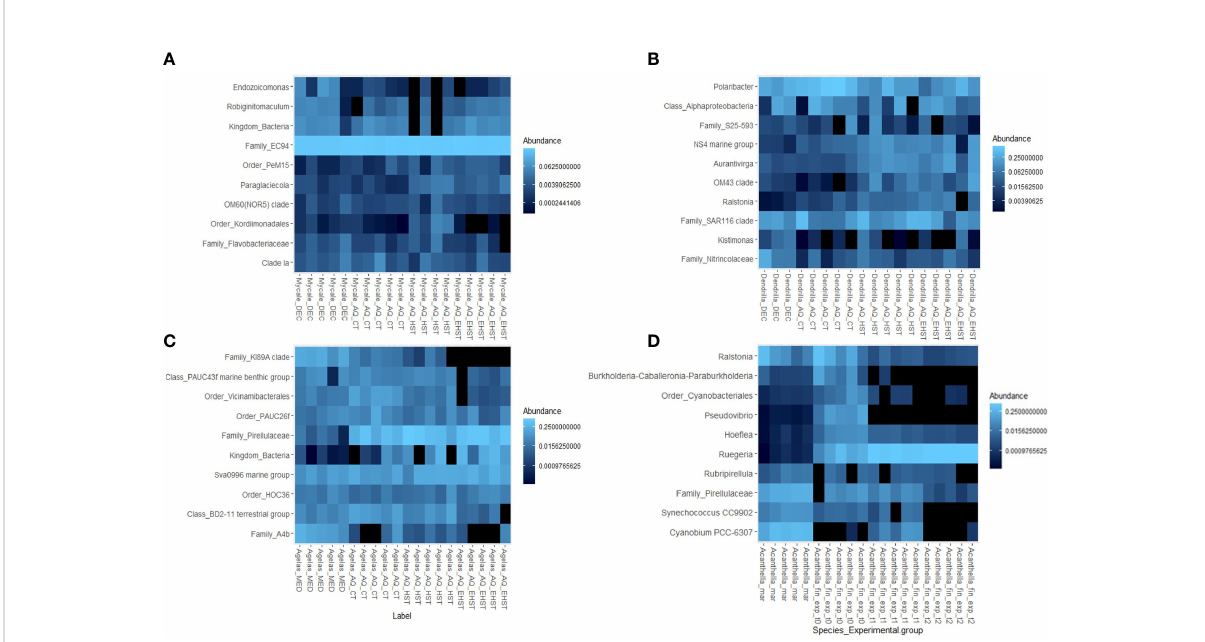
FIGURE 7 Heatmap representation of the abundance of the 10 most abundant genera from the core sponge communities of each sponge species in the different aquaria experimental groups exposed to different temperatures (CT, control temperature, HST, heat stress temperature, EHST, extreme heat stress temperature) and natural habitat: (A) M. acerata from Deception Island; (B) D . antarctica from Deception Island; (C) A. oroides from Cadaque ́ s and Roses; (D) A . cavernosa from Guam. AQ, aquarium